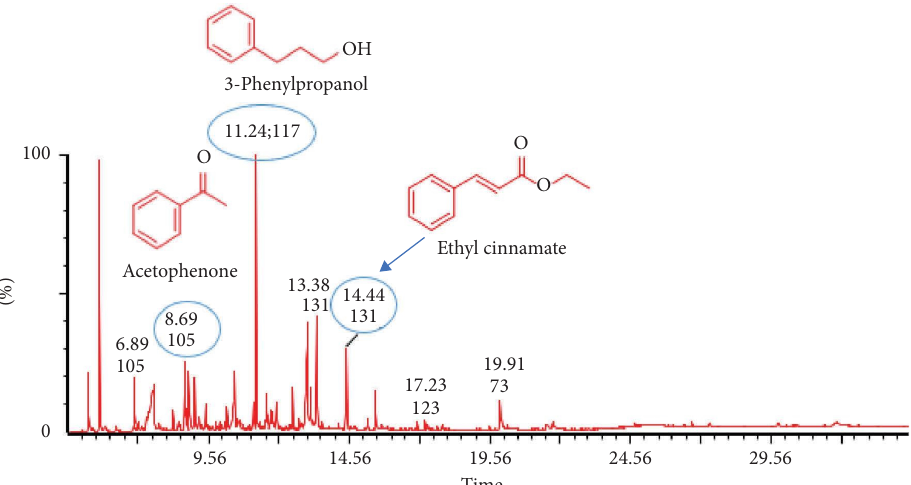
Figure 1: Total ion chromatogram (TIC) obtained from the GC-MS run of the fruit essential oil of Vitex doniana. Compounds were identifed by comparison of MS spectra data with the NISTand Wiley libraries, as well as published literature. Chemical structures of some of the compounds are shown and were drawn with ChemDraw.